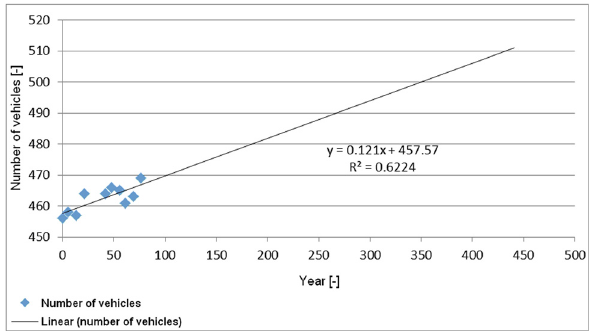
Figure 3: Parking demand forecast for 1 year.